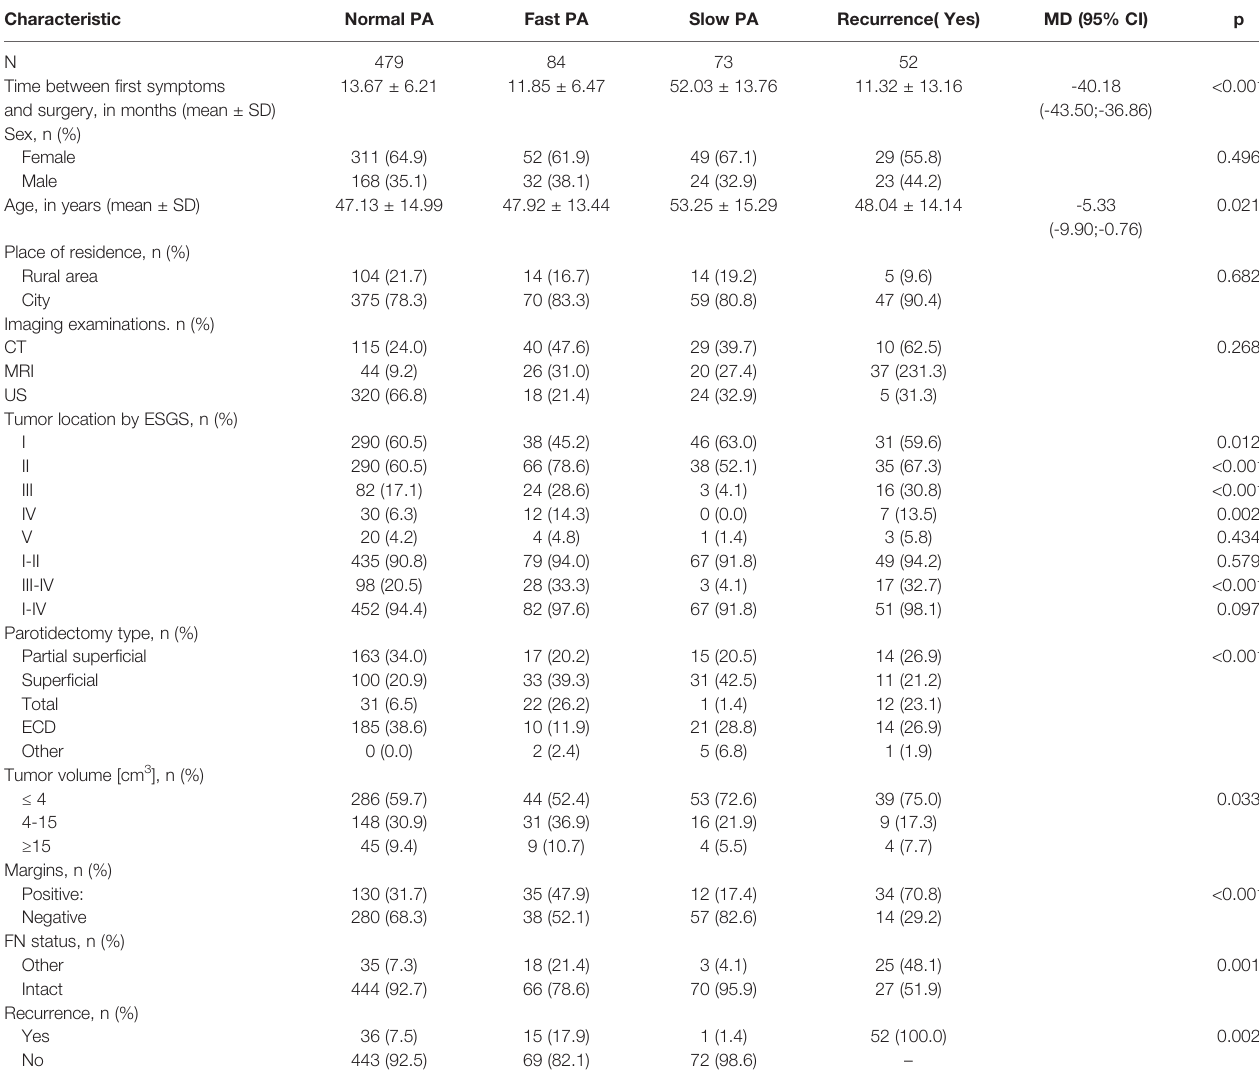
TABLE 3 | Analysis of fast and slow pleomorphic adenoma